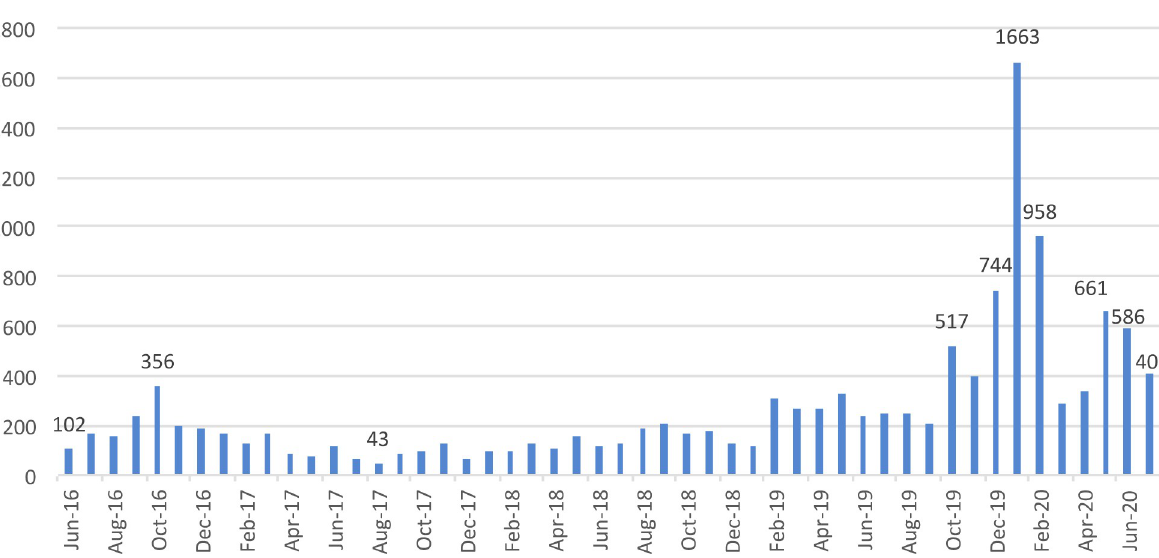
PLOS NeglectedTropical Diseases | https://doi.org/10.1371/journal.pntd.0010153 June 22,